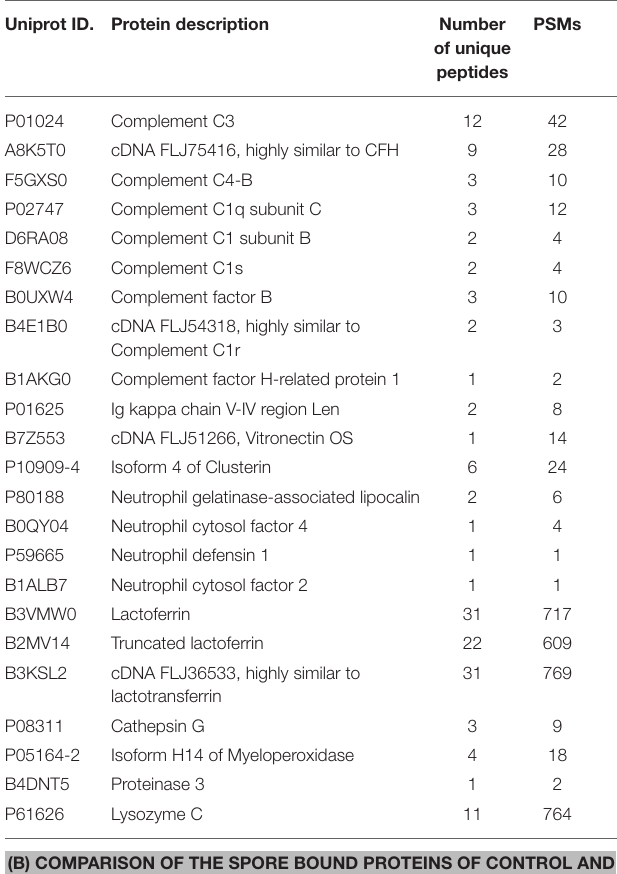
TABLE 1 | Hundred microgram of A. flavus keratitis patient tear was incubated with A. flavus conidia for 60min at 37 ◦ C. (A) IDENTIFICATION OF KERATITIS PATIENT TEAR PROTEINS BOUND TO A. flavus CONIDIAL SURFACE Uniprot ID. Protein description